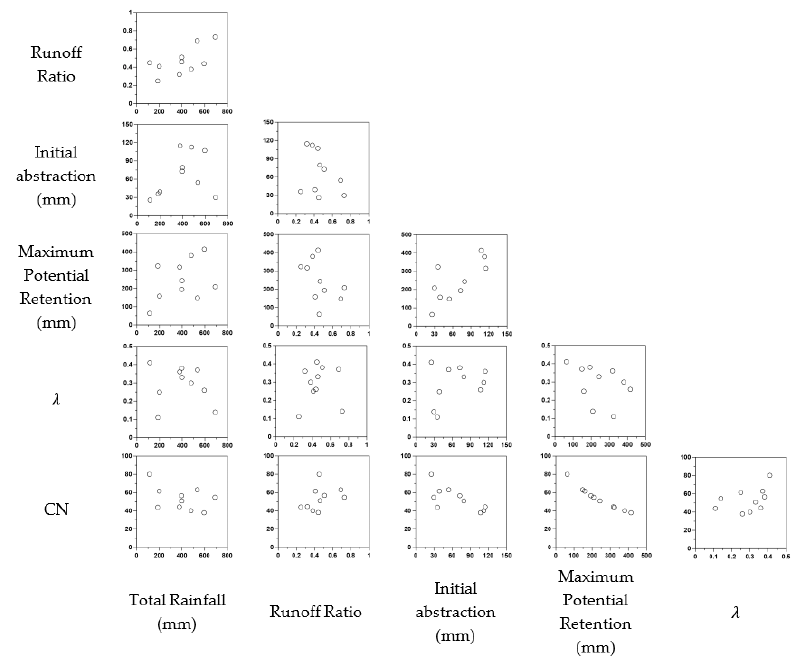
Figure 6. Scatter plots among total rainfall, runoff ratio, initial abstraction, maximum potential retention, 𝜆 and curve number (CN).